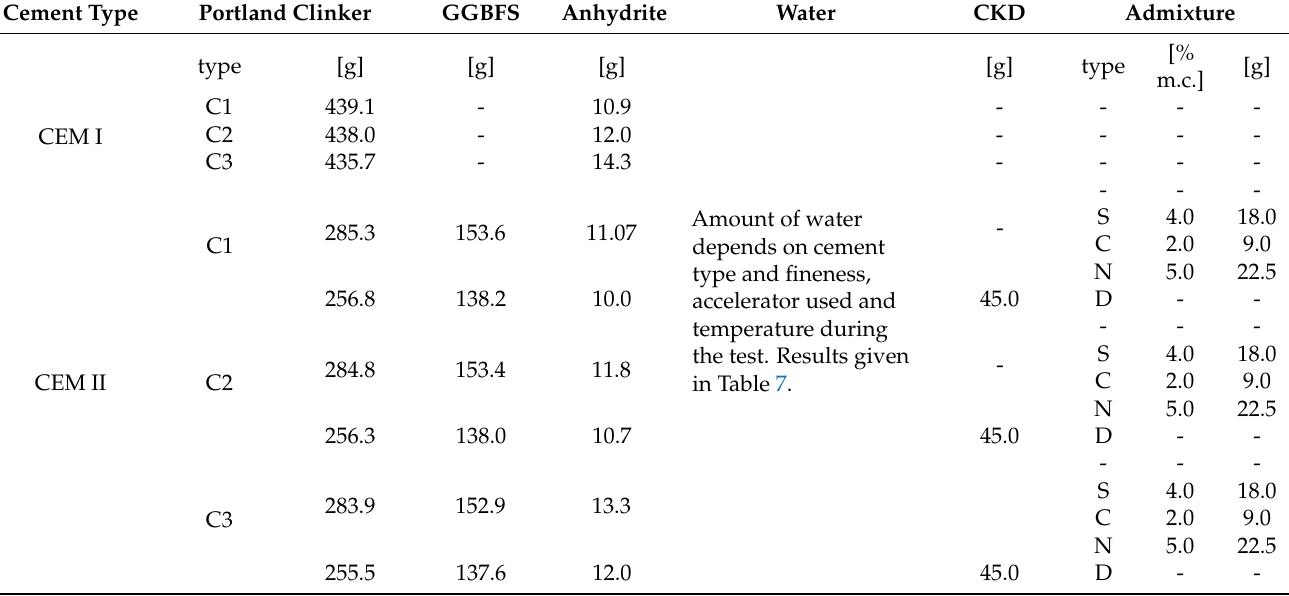
Table 6. Composition of cement pastes for initial setting time